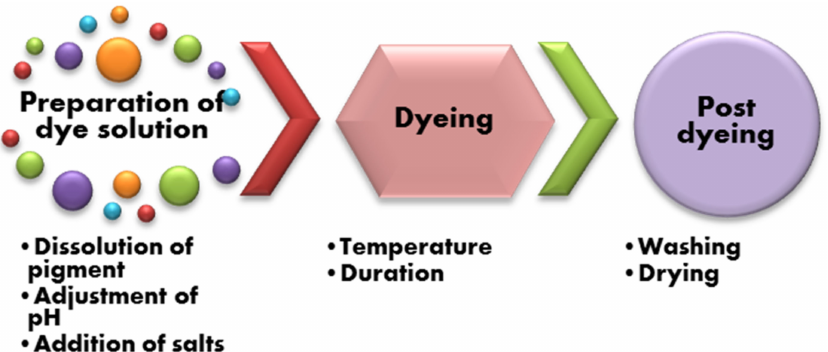
Figure 4. Scheme of phases for preparation and dyeing of textile material using microbial